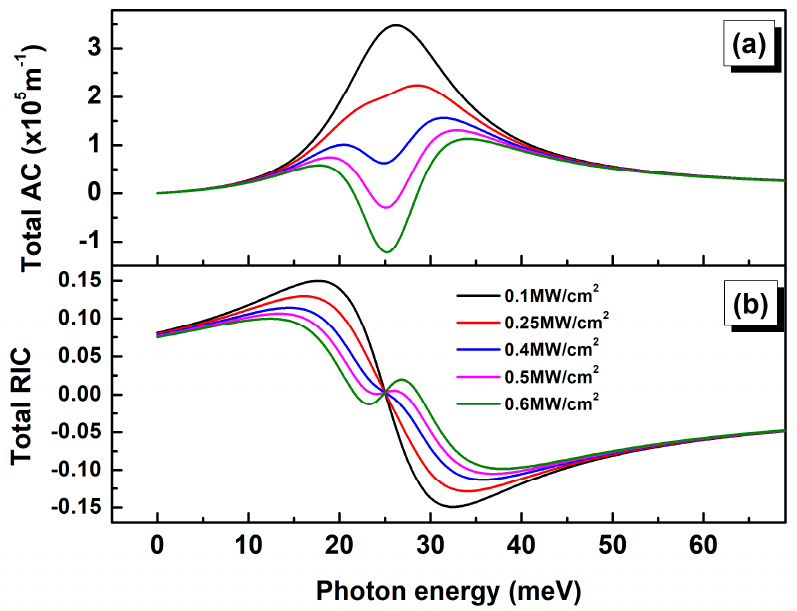
Figure 6. Incident optical intensity dependence of total optical AC ( a ) and RIC ( b ) as a function of the photon energy for D = 40 nm.